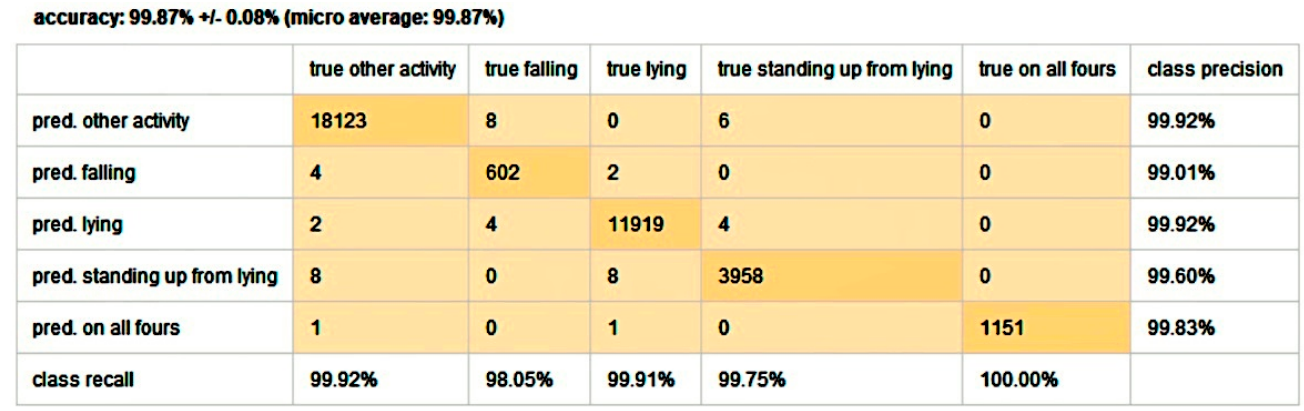
Figure 7. Confusion matrix representing the overall performance accuracy as well as the subclass precision values for the different activities—falling, lying, standing up from lying, being on all fours, and other activities, of the RapidMiner process shown in Figure 5 when the first dataset [50] was used.